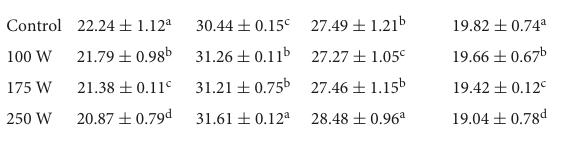
TABLE 1 Changes in the relative content of the secondary structure of the adsorbed protein in OBs under different ultrasonic power treatments.